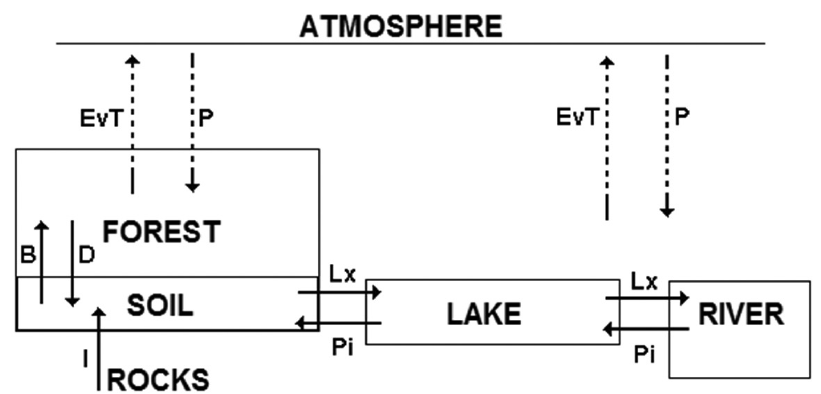
Figure 7. Inputs and outputs model of elements in Amazonian ecosystems of wetlands. EVT = evapotranspiration; P = precipitation; B = incorporation of nutrients into biomass; D = decomposition; I = weathering; Lx = leaching and erosion; Pi = flood pulse carrying nutrient-rich